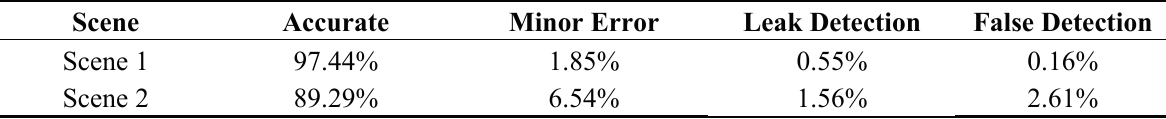
Figure 14. Distribution of process time for each frame in the urban scene ( a ) and the rural scene ( b ). Table 2. Statistics on ground segmentation and road curb